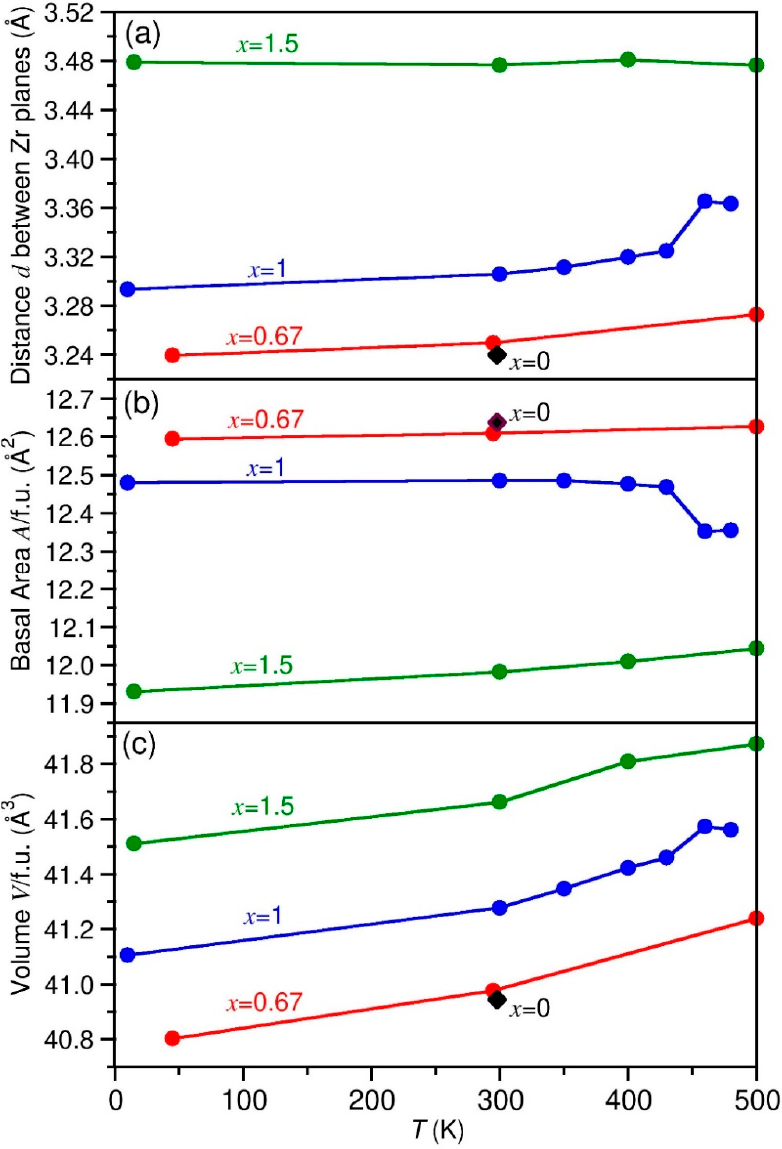
Figure 6. The lattice parameters of the three distinct ZrBe 2 H x compounds ( x = 0.67, 1, 1.5) as functions of temperature, as determined by NPD. The black diamonds denote values for x = 0 from Ref. 1. ( a ) distance d between Zr planes, equivalent to the c lattice constant for hexagonal P 6/ mmm symmetry; ( b ) average Zr basal-plane area A /ZrBe 2 H x formula unit (f.u.); ( c ) average volume V /ZrBe 2 H x f.u., where V = d × A .